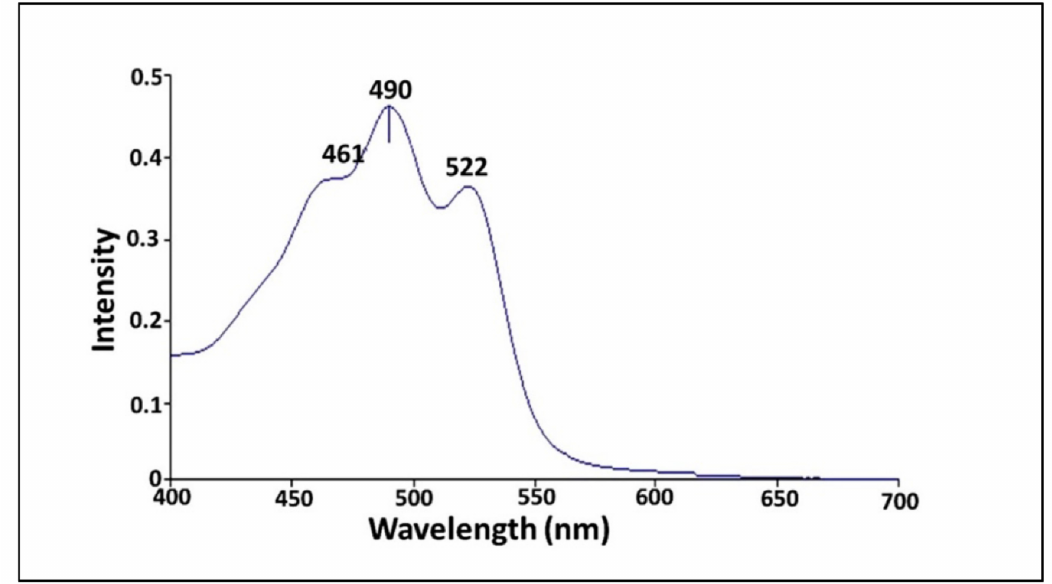
Figure 7. UV-Vis spectroscopy scanning of carotenoid pigments extracted from halophilic V. halodeni- trificans